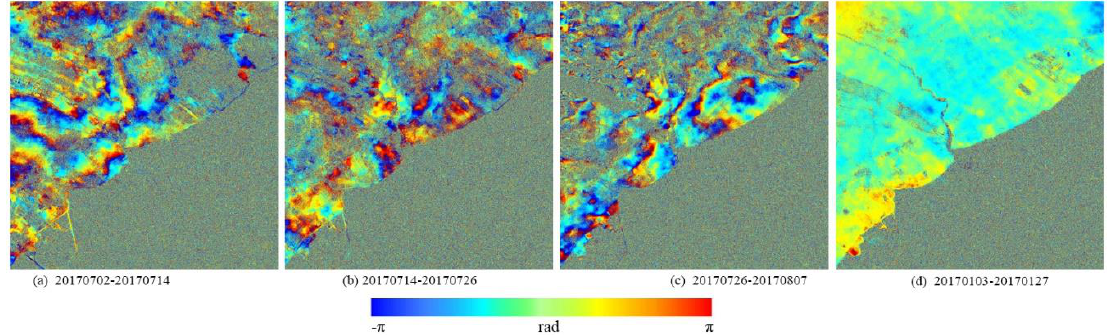
Figure 3. Interferograms formed by summer season images are strongly affected by atmospheric artifacts as shown in ( a – c ). In contrast, a good quality interferogram formed by two winter images is shown in ( d ).